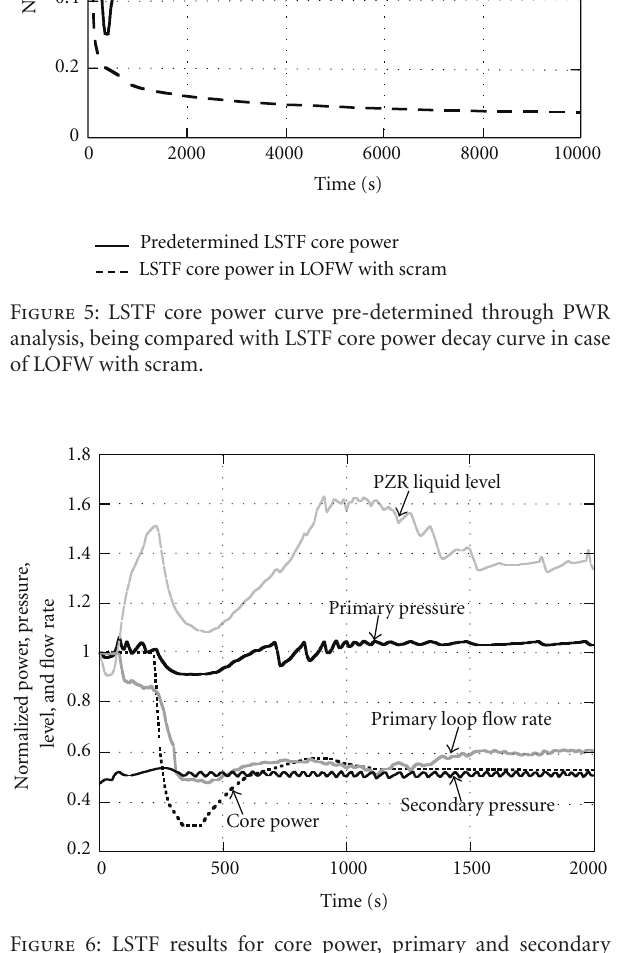
Figure 8: LSTF and RELAP5 results for hot leg liquid level in loop with